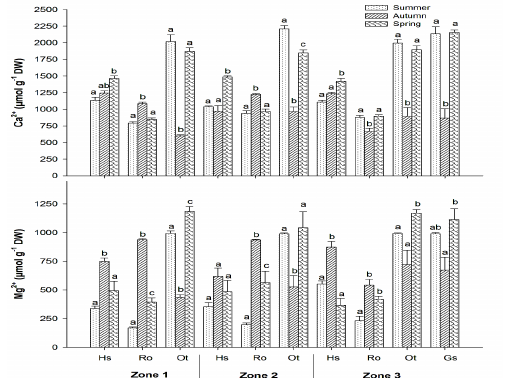
Fig. 5. Variation of bivalent cation (Ca 2+ and Mg 2+ ) contents in the investigated taxa, in the three plots under study in summer 2009, autumn 2009 and spring 2010. Different letters indicate seasonal significant differences within each species and plot. Species